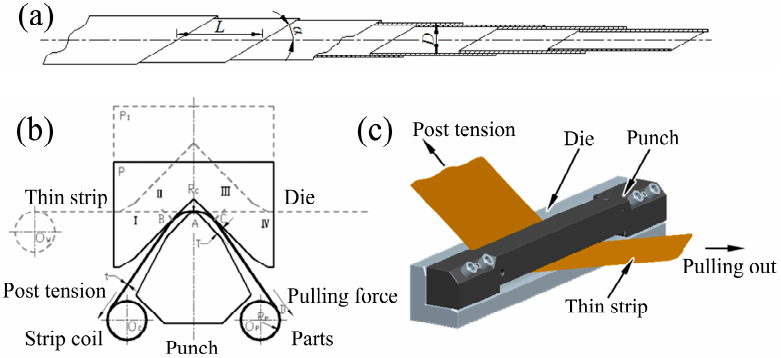
Figure 1. Schematic plot of STACER ( a ), the principle of the CSPB process ( b ), and its model diagram ( c ).